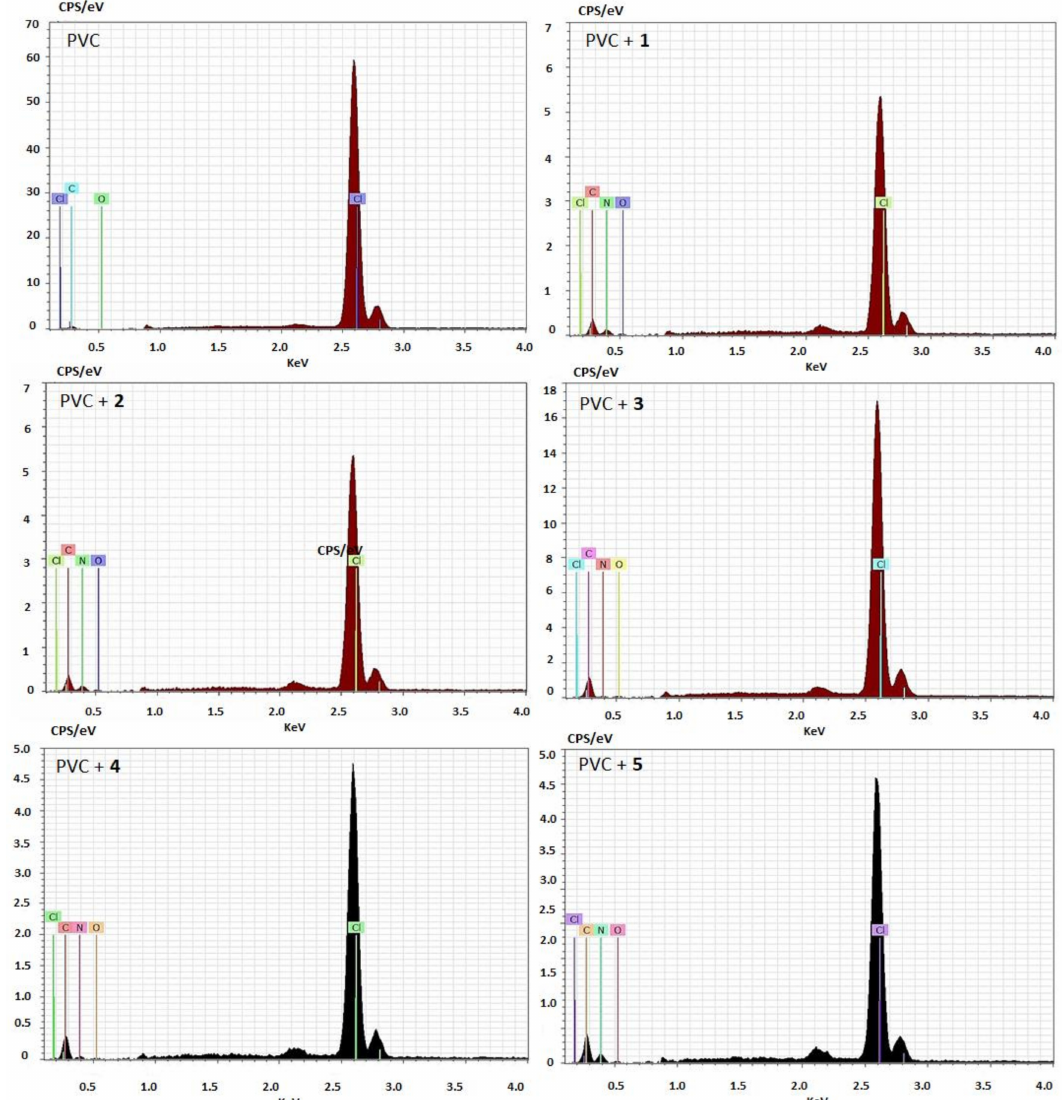
Figure 2. Energy dispersive X-ray (EDX) patterns of poly(vinyl chloride)